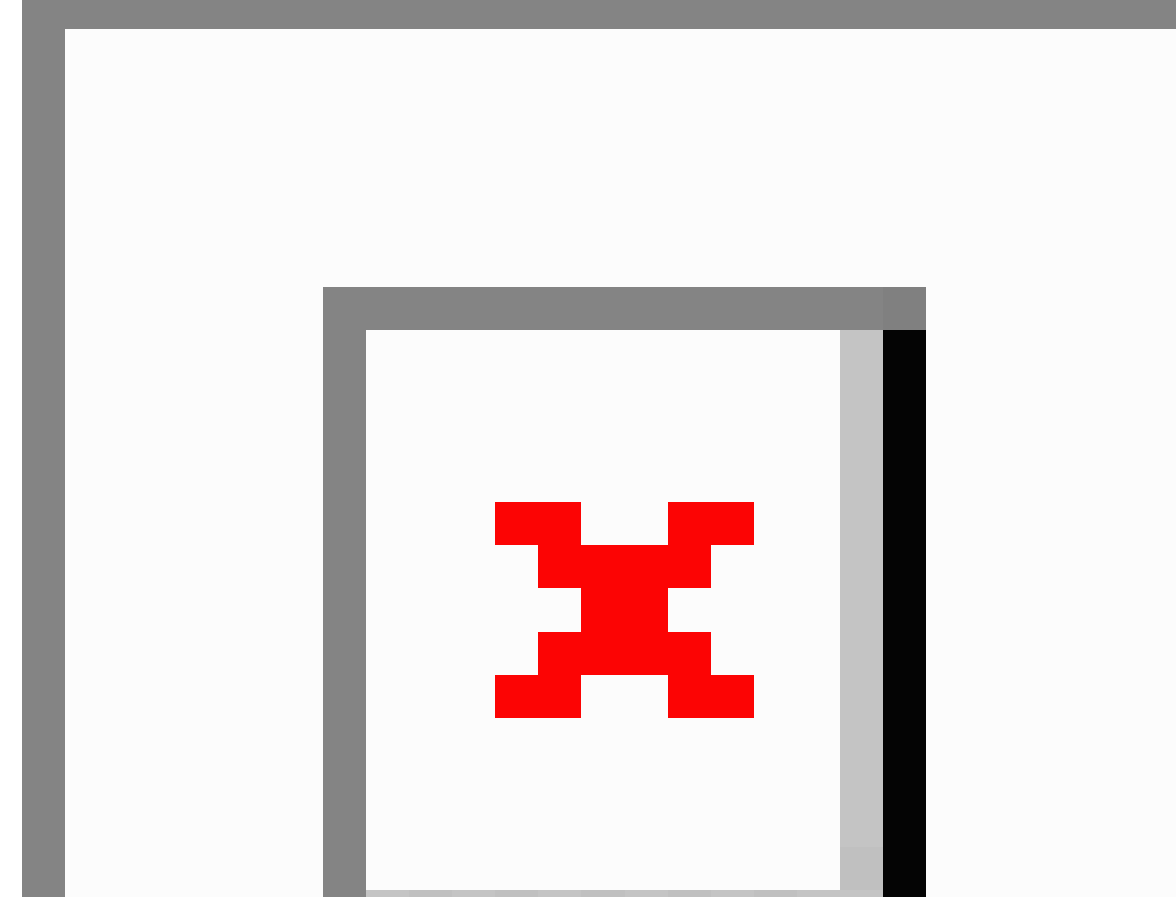
Figure 2. Example screenshots of the InDEx app measurement (questionnaire) module. Source: King’s Centre for Military Health Research, King’s College